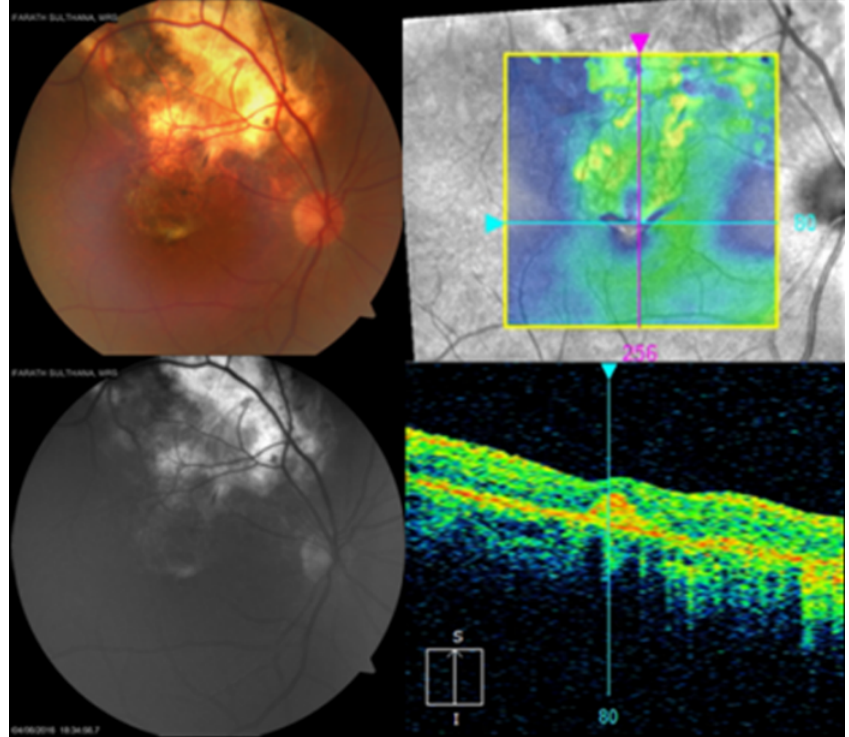
Figure 9: At one-year follow-up, fundus picture showed healed, pigmented scarred lesion at fovea. OCT showed reduced thickness, scarred lesion with partial restoration of foveal